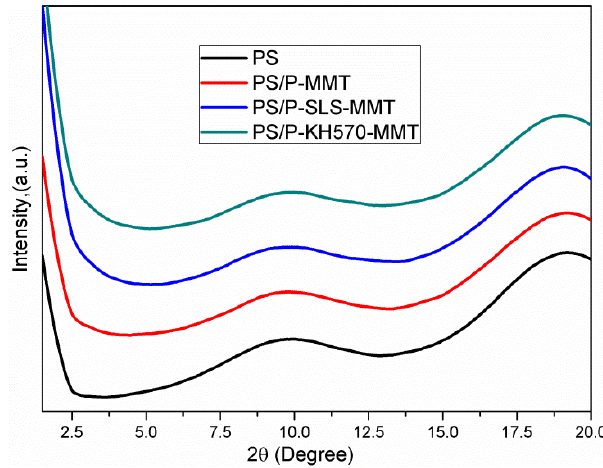
Figure 6. XRD patterns of PS, PS/P-MMT, PS/P-SLS-MMT, and PS/P-KH570-MMT.